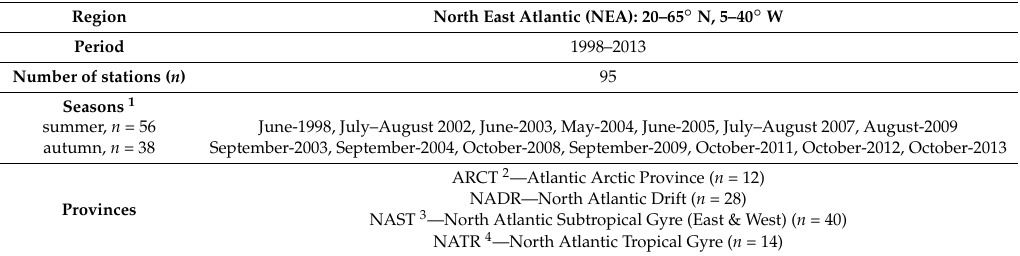
Table 1. Provinces and time periods for in situ integrated daily water column primary production ( PP eu ) (mg C m − 2 day − 1 ) used for the accuracy assessment of the primary production satellite